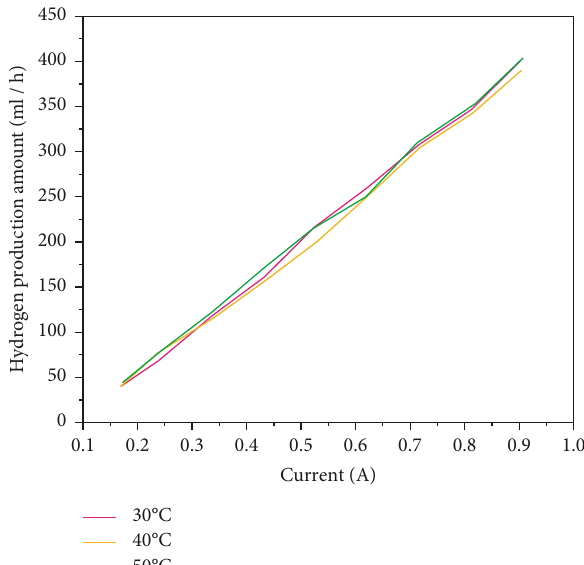
Figure 9: Variation of hydrogen production from electrolytic water with temperature under the condition of 0.5% dilute sulfuric acid.